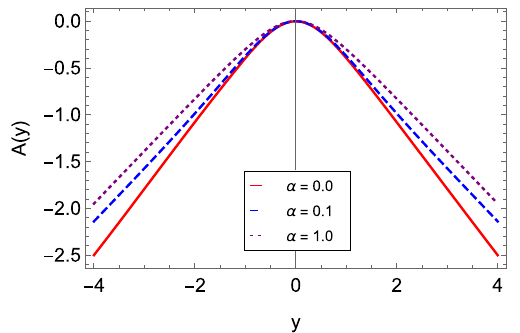
Fig. 3 Warp function A ( y ) resulting from Eq. (42) with φ 0 = k = 1 for different values of α